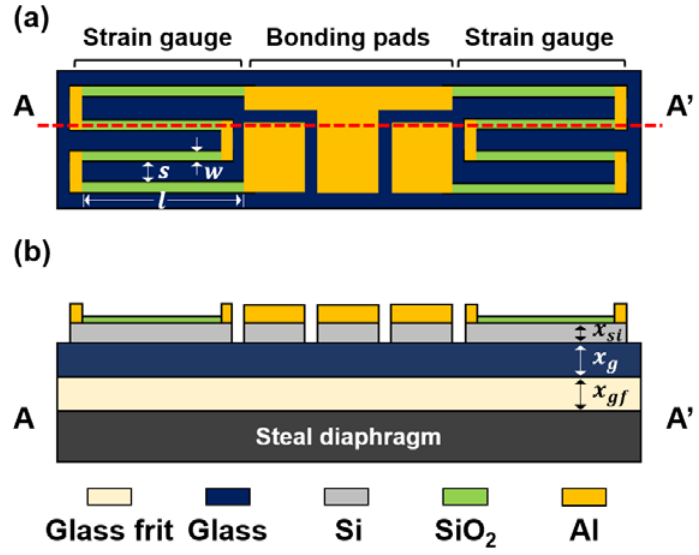
Figure 1. Layout ( a ) and cross-sectional view ( b ) of an Si strain gauge chip. The main design parameters